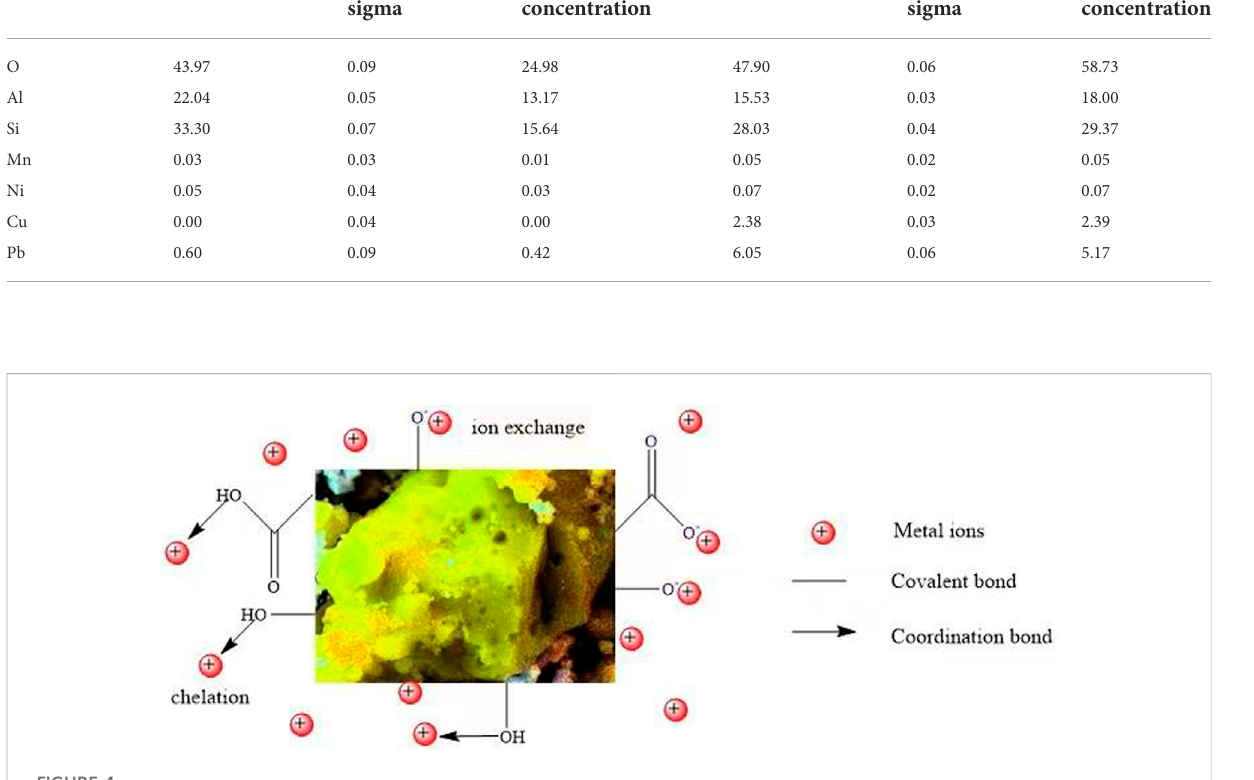
FIGURE 4 Adsorption mechanism of HM ions on the surface of